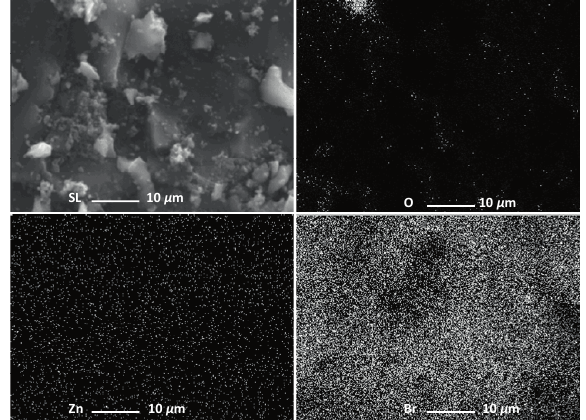
Figure 5. Electron probe microanalysis images of solid residue obtained after the 40 min. thermal scanning of TBBP:ZnO (3.34:1) at 1173 K in Argon